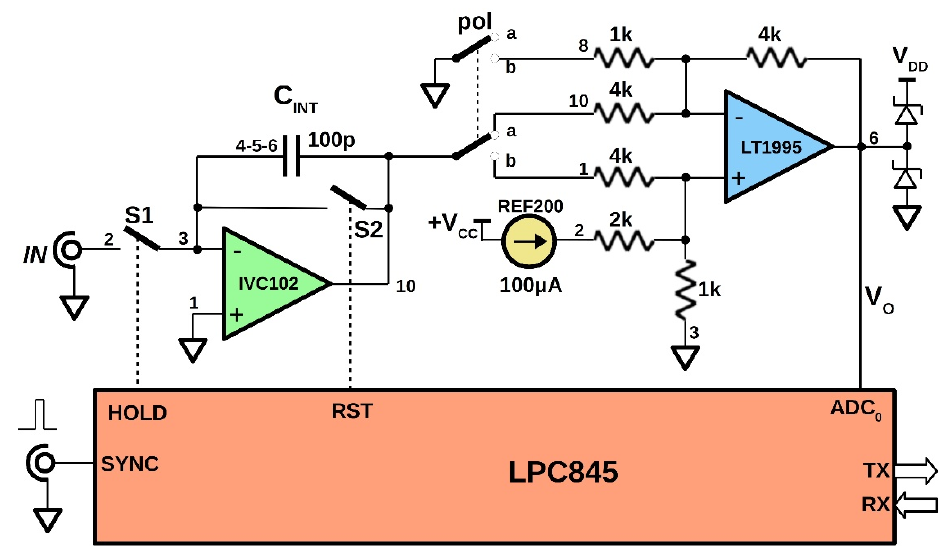
Figure 1. Schematic of the IVC102-based gated integrator. The LPC845 microcontroller implements the firmware used for input pulsed-current measurements synchronized with the SYNC signal.